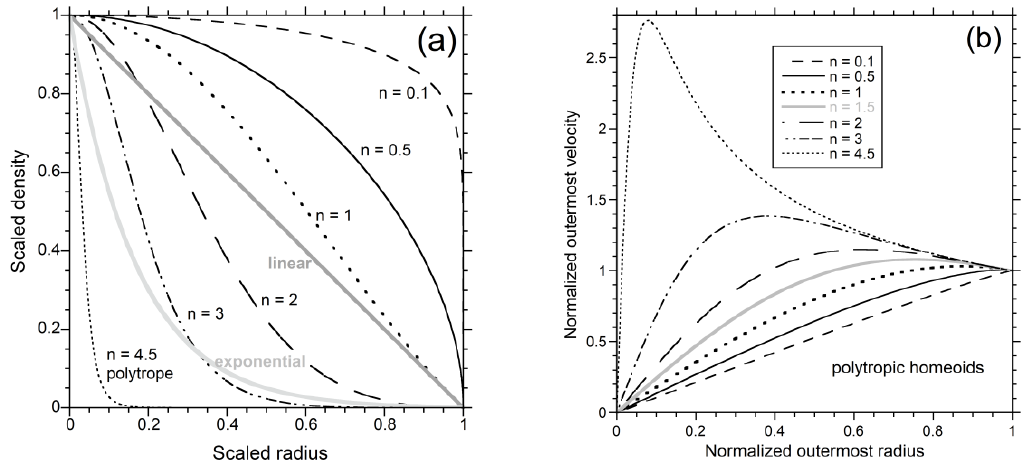
Figure 13. Polytropic model for galaxies: ( a ) Density for polytropes (black patterns, with indices labeled, which are normalized to the central density as a function of scaled radius normalized to unity at the center and zero at the surface ( r = a ). Index n = 0 for constant density is not shown. Gray shows linear and exponential densities for comparison. Reproduction of Figure 4b from Hofmeister and Criss [14], which is open access under a Creative Commons Attribution 4.0 International License: ( b ) Rotation curves for differentially rotating homeoids inside an oblate with the same ellipticity. During the normalization factors involve the ellipticity cancel.